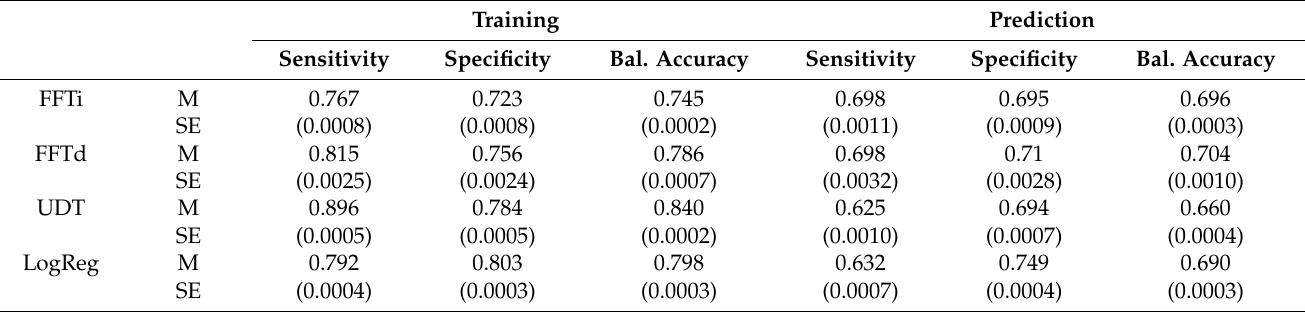
Table 3. Average performance of algorithms across trials with full information. The table presents means and standard errors separately for the four algorithms with the training set (fitting) and test set (prediction). For each combination, the table reports the mean and standard error of the mean for sensitivity, specificity and balanced accuracy across trials. FFTi, UDT and LogReg were tested in 10,000 trials and FFTd in the first 1000 of these only.